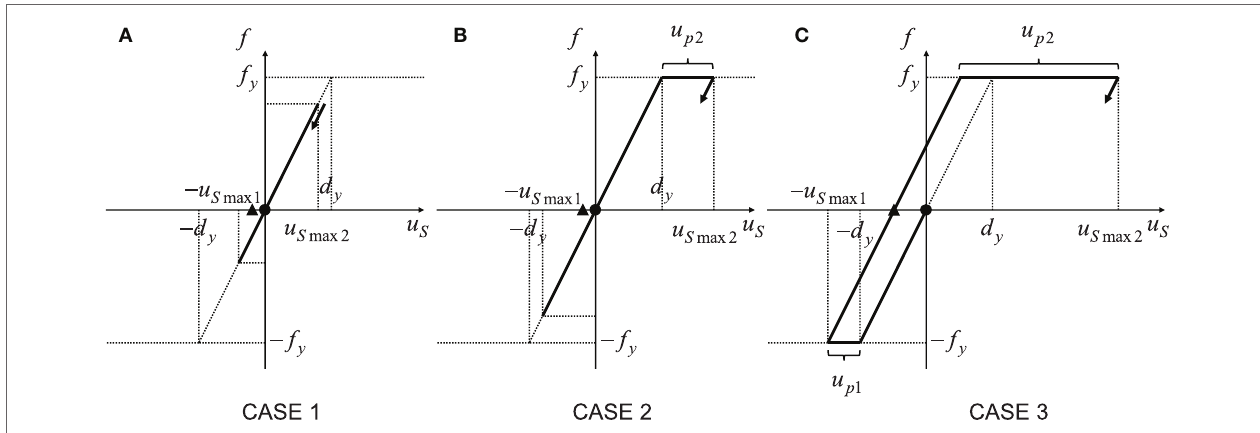
FigUre 8 | Prediction of maximum elastic–plastic deformation of superstructure on compliant ground under double impulse based on energy approach: (a) case 1: elastic response; (B) case 2: plastic response after the second impulse; and (c) case 3: plastic response after the first impulse ( • : first impulse,  : second